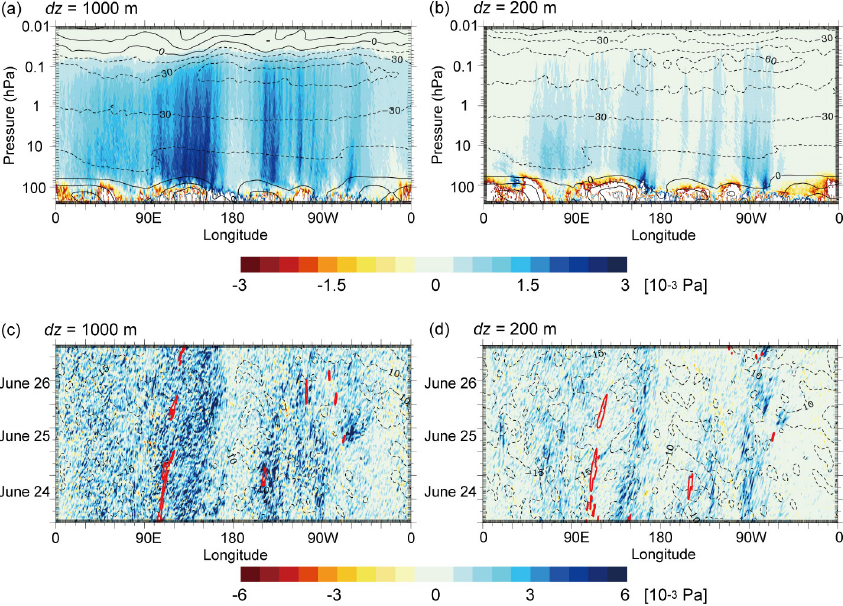
Figure 2. Upper panels: longitude–height distribution of net upward flux of the eastward momentum associated with the gravity wave component ( λ h < 950km) in the d z = 1000m run (a) and d z = 200m run (b) . The contours show low-pass filtered ( > 1000km) eastward winds with an interval of 15ms − 1 . Averages over 35–40 ◦ N from 00:00UT, 24 June, to 00:00UT, 27 June, are shown. Lower panels: Hovmöller diagrams of the eastward gravity wave momentum flux (color) and the background large-scale eastward winds (black contours with an interval of 5ms − 1 ) at 30hPa in the d z = 1000m run (c) and d z = 200m run (d) . Red contours show precipitation rate of 2mmh − 1